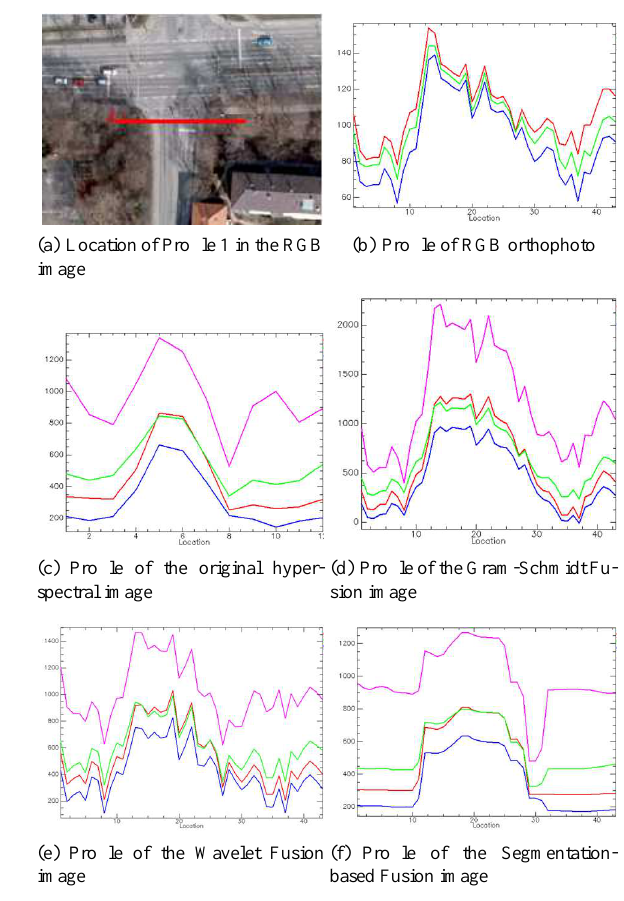
Figure 7: Profile 1 for different Fusion